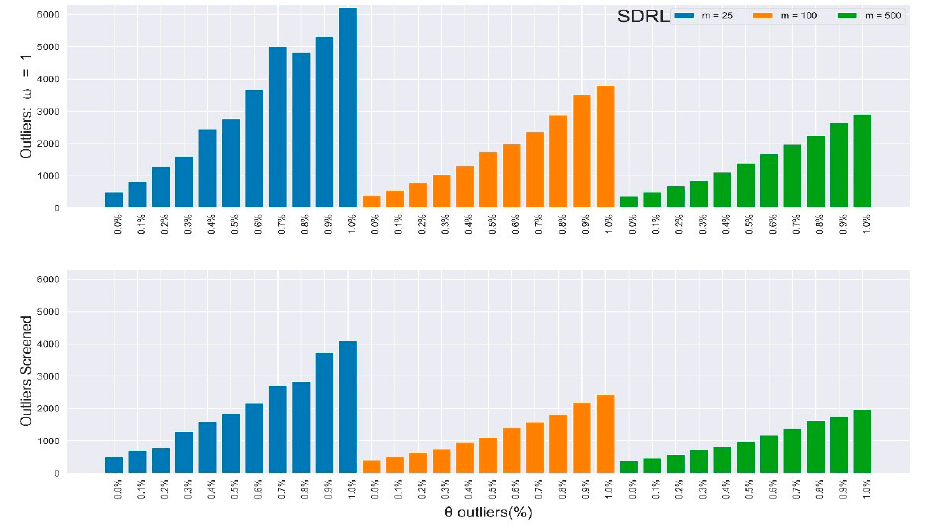
Figure 3. In-control SDRL values of the multivariate Shewhart chart from a mixed distribution with and without SDRE multivariate outliers screening ((cid:2033) = 1) .